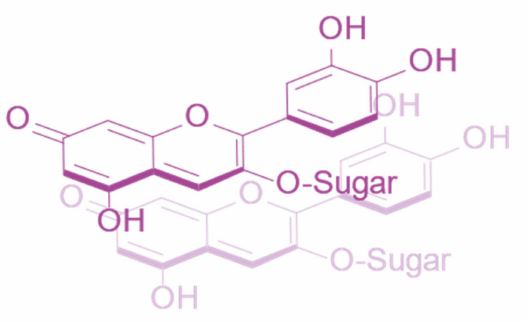
Figure 3. Self-association interaction between two cyanidin-3- O -glucoside quinonoid bases. This self-associative behaviour is dependent on the substitutions present on the